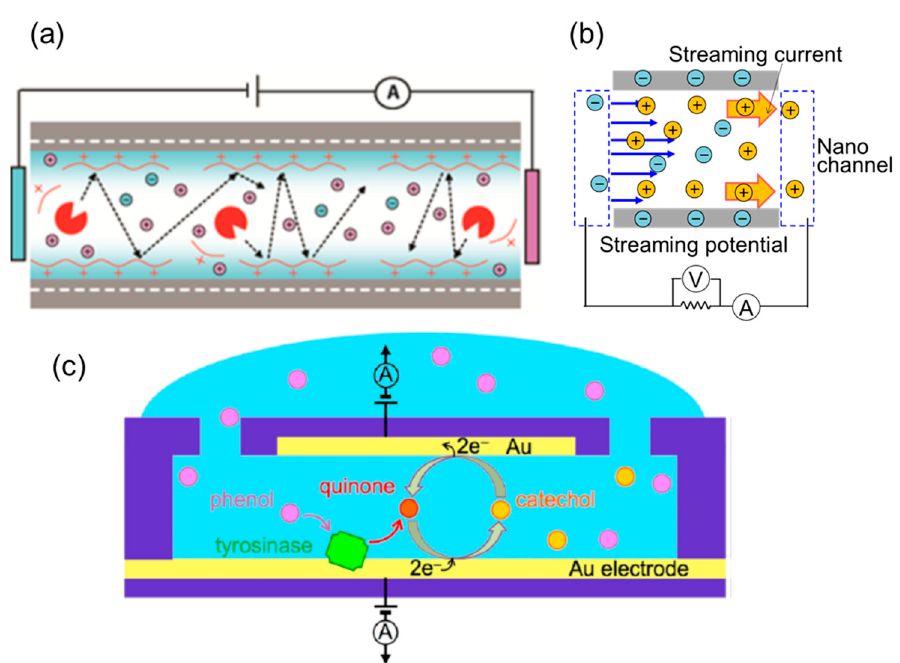
Figure 5. Nanofluidic devices for electrical / electrochemical detection, ( a ) detection of conductivity on nanochannel surfaces during chemical reaction (adapted with permission from [90]. Copyright 2016 American Chemical Society), ( b ) detection of streaming current / potential induced by pressure-driven flow in a nanochannel (adapted with permission from [115]. Copyright 2015 American Chemical Society), and ( c ) detection of electrochemical reaction using electrodes integrated in a nanochannel. (adapted with permission from [120]. Copyright 2014 American Chemical Society).